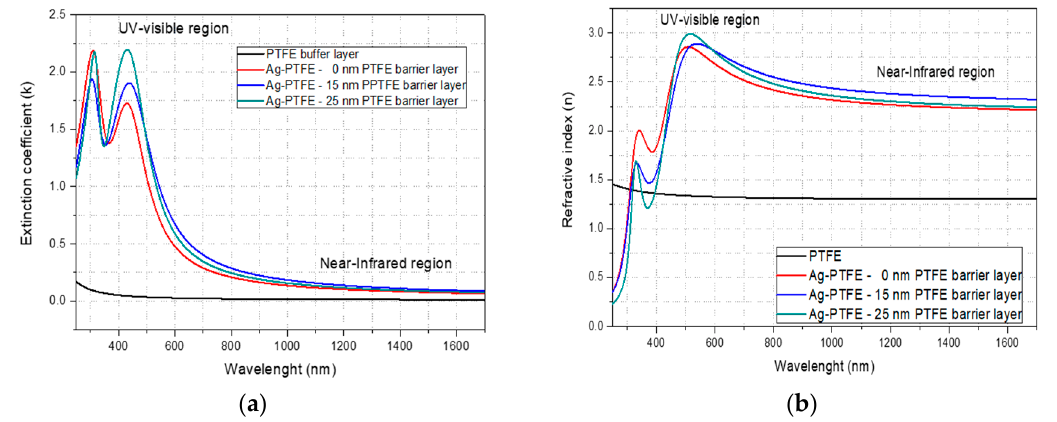
Figure 9. Dependency of the extinction coefficient ( a ) and refractive index ( b ) upon the wavelength for pure PTFE material and Ag-PTFE nanocomposites with various thickness of PTFE top coat layer.